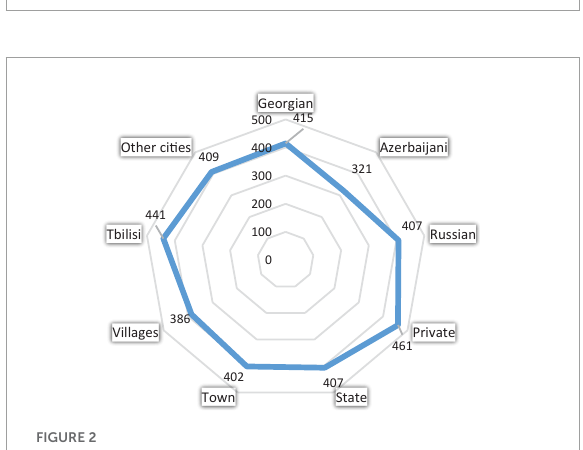
FIGURE2 Students’ grade in natural sciences by type of